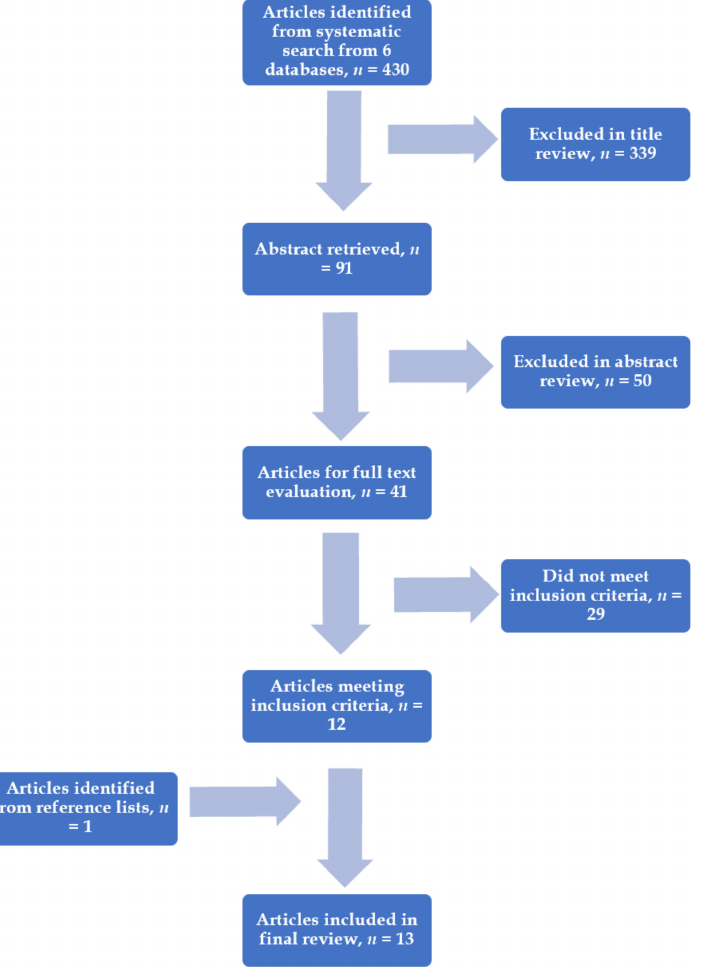
Figure 1. Flow diagram showing the literature